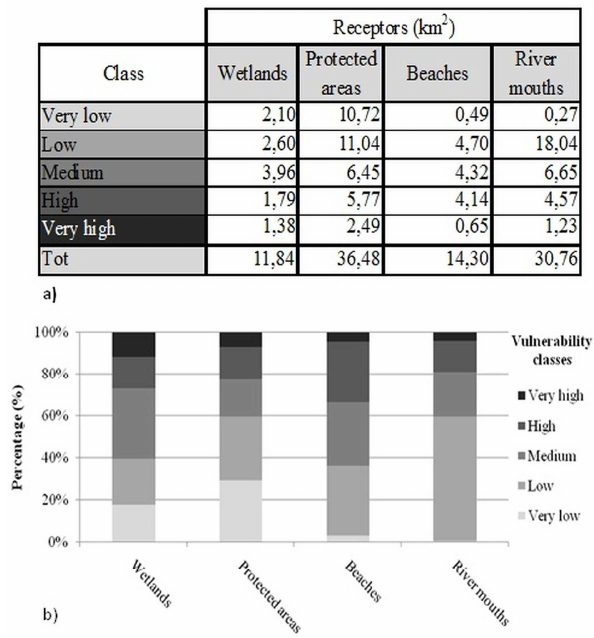
Fig. 10. Distribution of the territorial surface (km 2 ) (a) and of the percentage of surface (b) associated with each vulnerability class for the receptors located on the North Adriatic coast for the coastal erosion